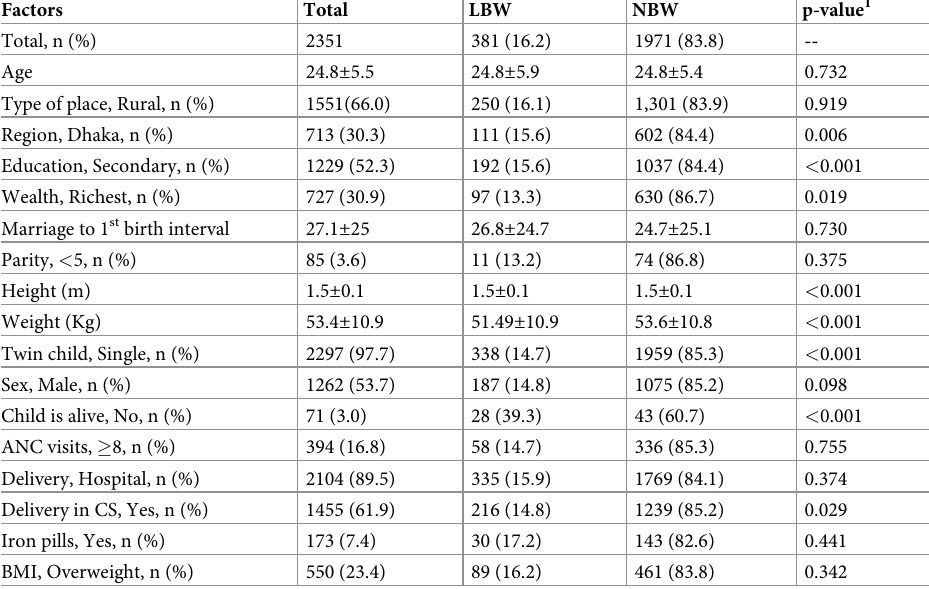
Table 2. Baseline and demographic characteristics of LBW